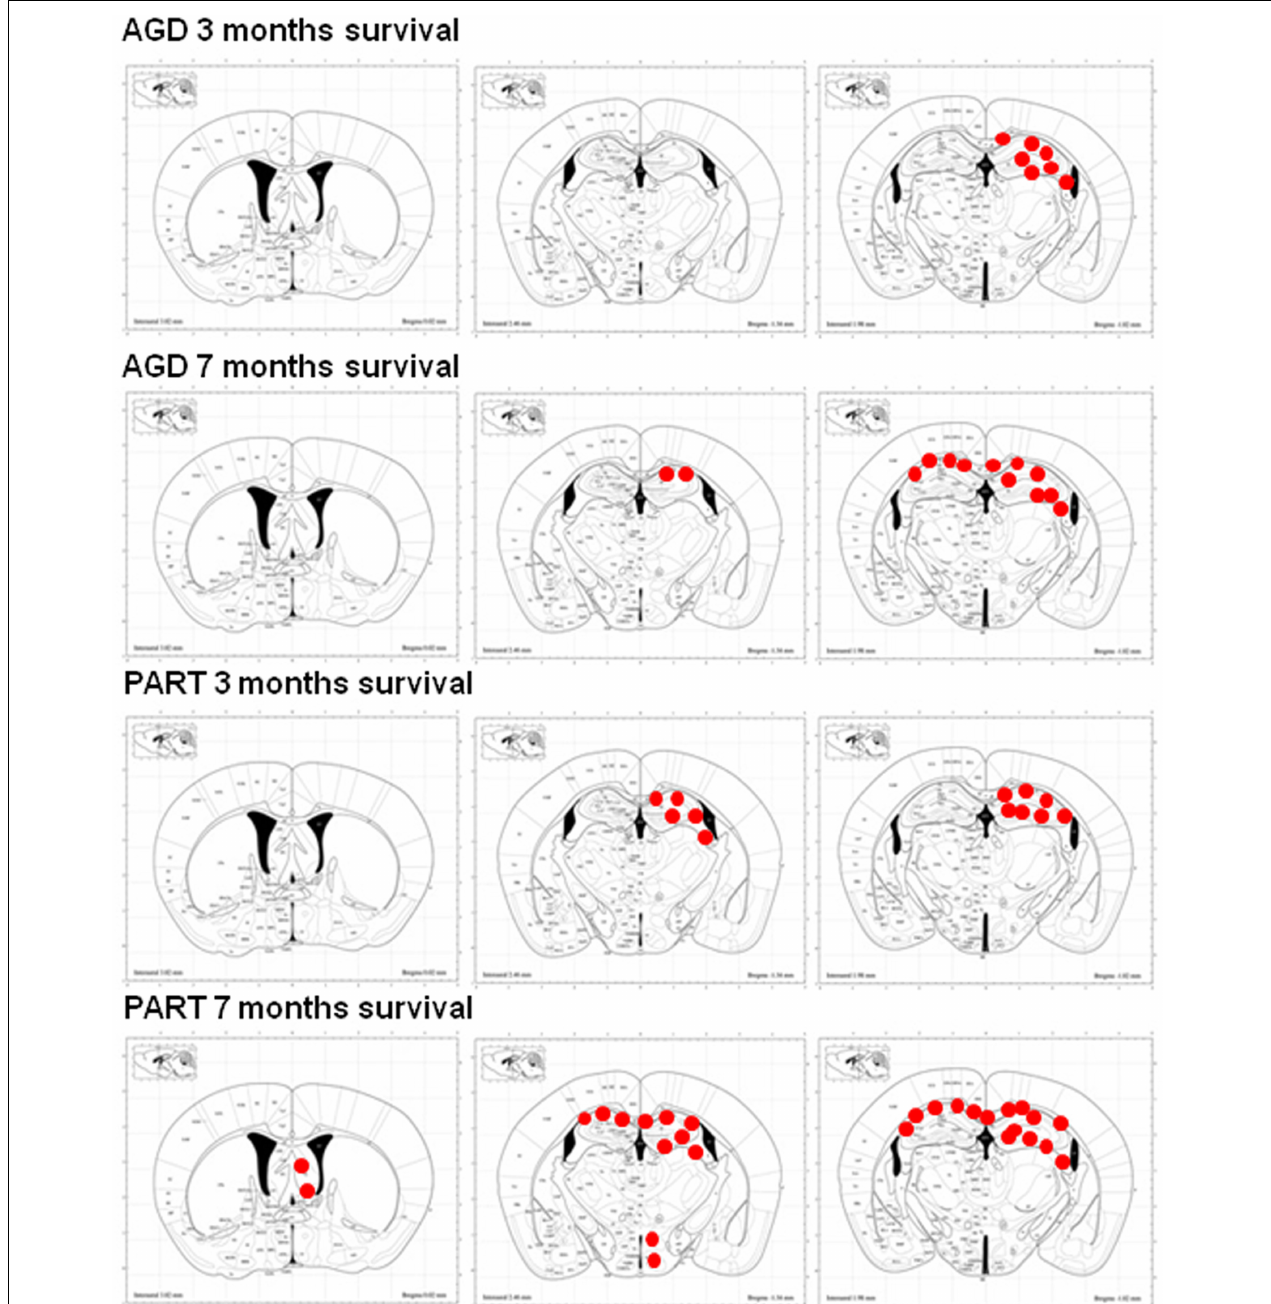
FIGURE 5 | Schematic representation of phospho-tau-immunoreactive deposits (red dots), as revealed with the AT8 antibody, following unilateral inoculation of sarkosyl-insoluble fractions from AGD and PART into the hippocampus of WT mice with survival times of 3 and 7 months. Mice inoculated with AGD and killed 3 months after inoculation show tau deposits restricted to the ipsilateral hemisphere, whereas mice inoculated with PART and killed after 3 months show wider distribution of tau deposits along the anterior-posterior axis although restricted to the same hemisphere. Mice inoculated with AGD and killed 7 months later have, in addition, tau deposits along the contralateral corpus callosum, whereas mice inoculated with PART and killed at 7 months post-inoculation show, in addition to the previous regions, further extension along the anterior-posterior axis, deposits in distal projections such as the periventricular hypothalamus and septal nuclei, and abundant deposits in the contralateral corpus callosum. Maps obtained from the atlas of Paxinos and Franklin. Red dots simply represent the distribution of lesions; no attempt is made to distinguish between deposits in neurons, oligodendrocytes, threads and dots, and quantify the numbers or densities of each one of these